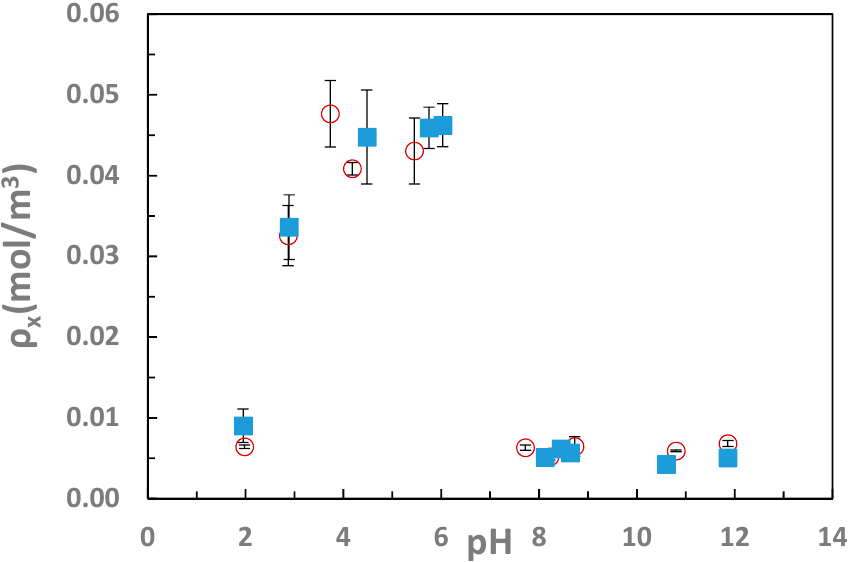
Figure 5. Crosslink density as a function of pH. A drastic difference between the collapsed state between pH 3 and 6 can be seen compared to pH values greater than eight or less than 2.